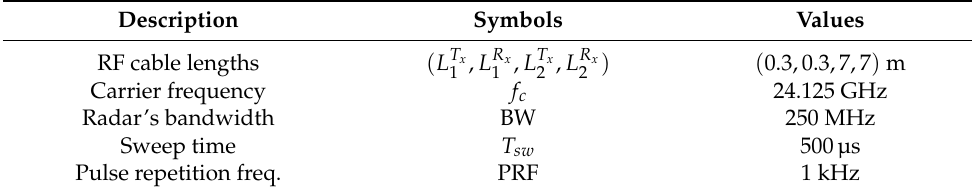
Table 2. System parameters of the 2 × 2 MIMO experimental setup. Description Symbols Values ) ( 0.3,0.3,7,7 ) m RF cable lengths ( L T x , L R x , L T x , L R x 2 2 1 1 Carrier frequency f c 24.125 GHz Radar’s bandwidth BW 250 MHz Sweep time T sw 500µs Pulse repetition freq.